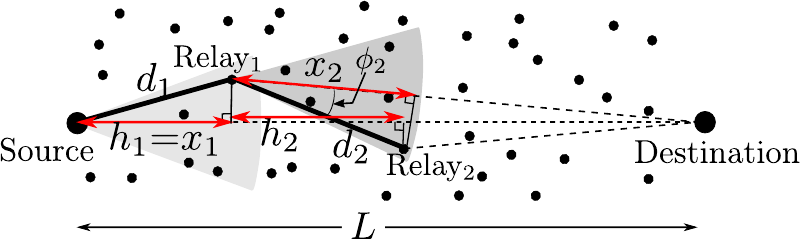
Figure 4. An example illustration of a multi-hop